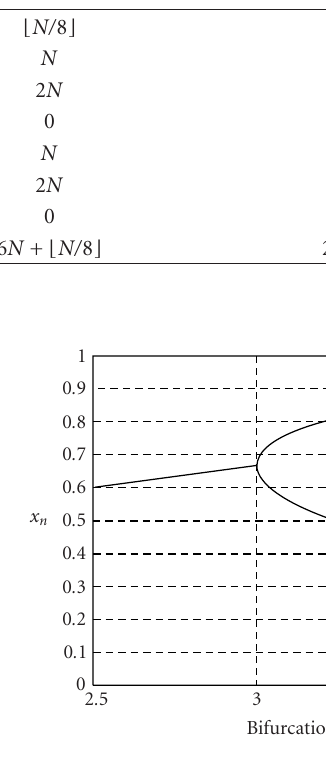
Figure 2: Bifurcation diagram of the logistic map g µ ( x ) = µx (1 − x ).